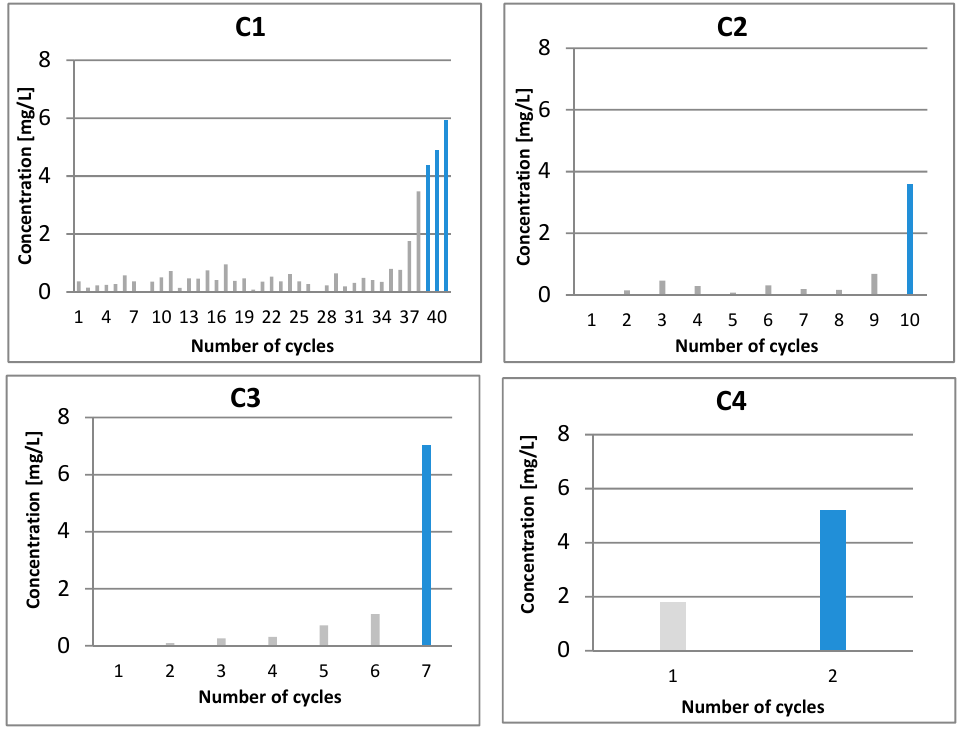
Figure 4. Concentration of Reactive Black 5 in permeates as a function of the numbers of cycles; rless (bluenhow